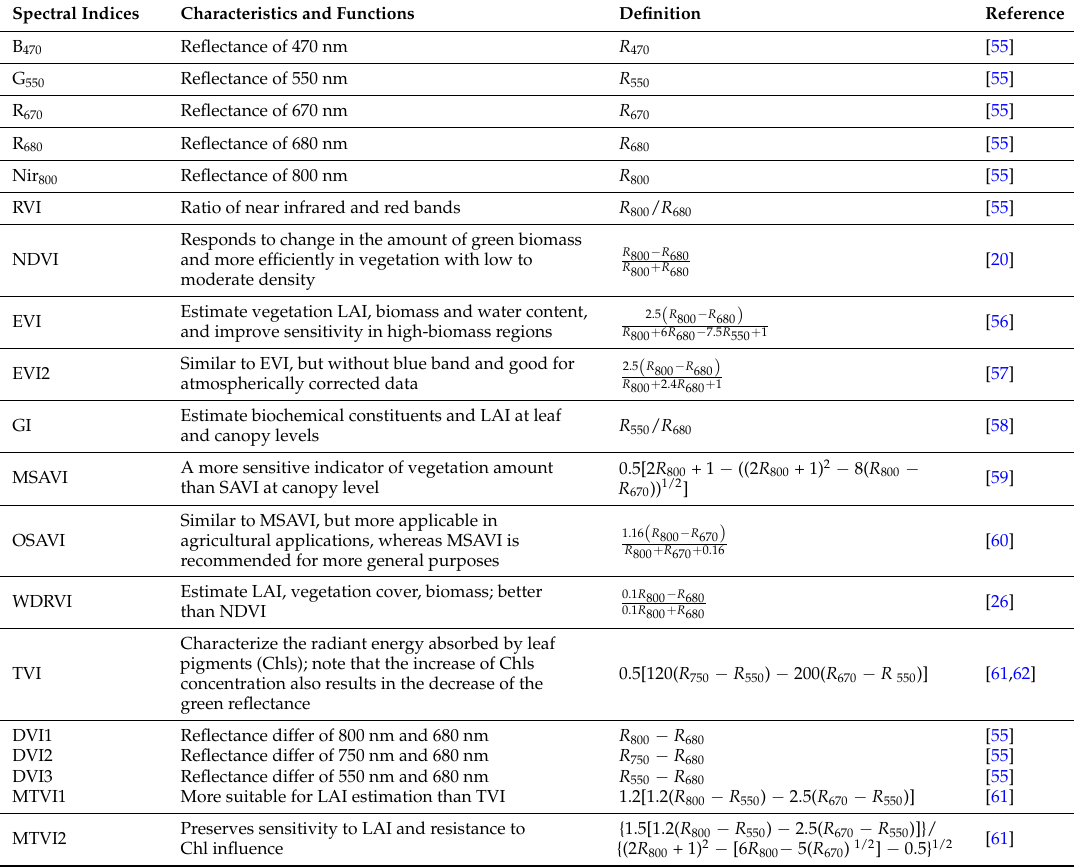
Table 1. Specific bands and Spectral vegetation indices. Ratio Vegetation Index (RVI) [55], the Normalized Difference Vegetation Index (NDVI) [20], Enhanced VI (EVI) [56], Two-band Enhanced VI (EVI2) [57], the Greenness Index (GI) [58], the Modified Soil-Adjusted Vegetation Index (MSAVI) [59], the Optimized Soil Adjusted Vegetation Index (OSAVI) [60], Wide Dynamic Range VI (WDRVI) [26], Triangular VI (TVI) [61,62], Difference Vegetation Index (DVI1, DVI2, DVI3) [55], Modified Triangular VI (MTVI1) [61] and Modified Triangular VI